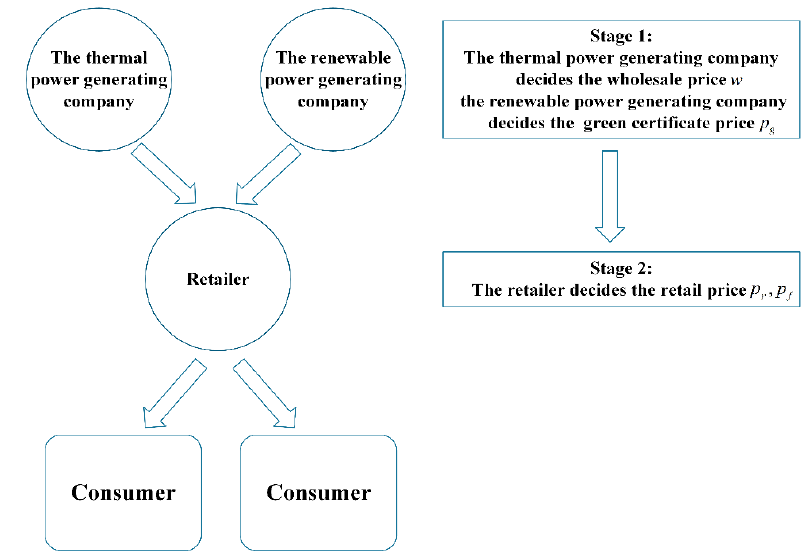
Figure 1. The supply chain network structure of the decentralized decision in case 1.